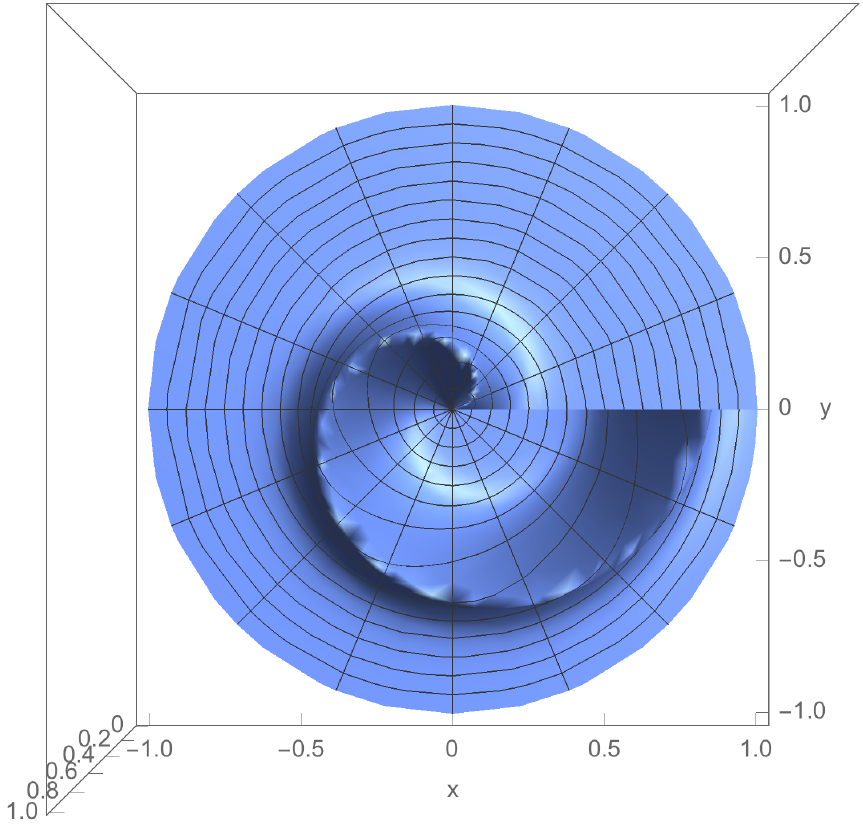
Figure 2. The top view of the wave as a solution given by Equation (4) of